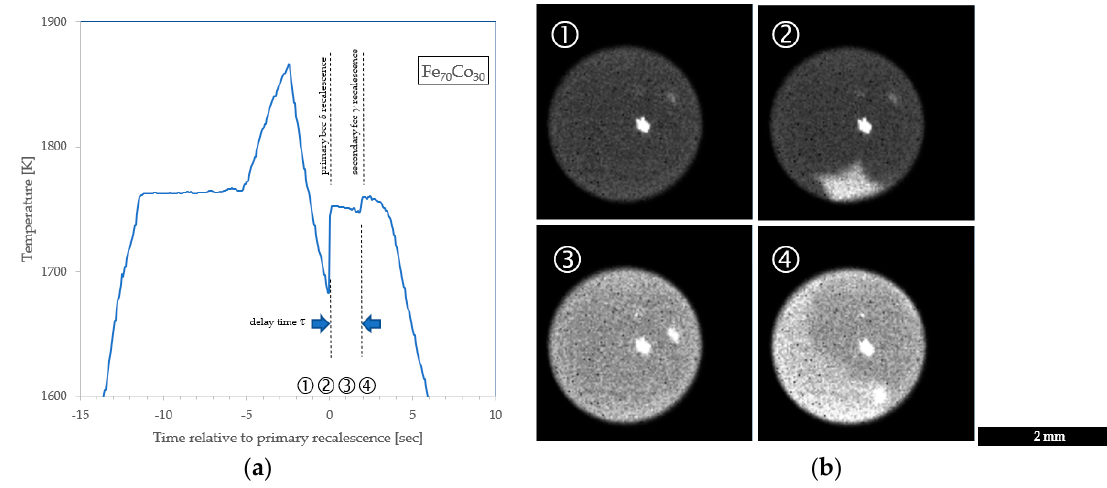
Figure 2. Double recalescence. ( a ) Thermal profile from Fe 70 Co 30 pyrometry with annotation of timing of key events; ( b ) mosaic of Fe 60 Co 40 images showing ① undercooled liquid, ② growth of metastable primary phase, ③ isothermal metastable phase mushy zone delay, and ④ growth of secondary stable phase.